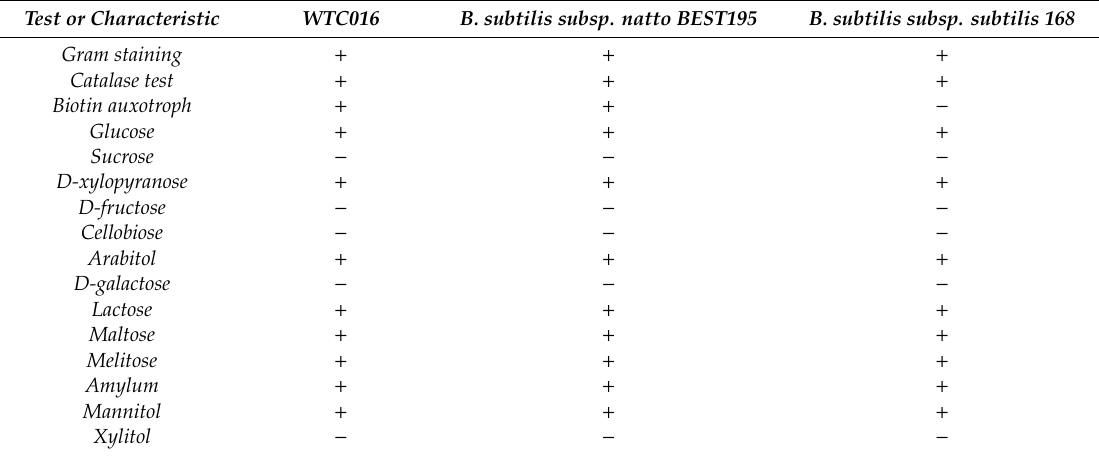
Table 2. Physiological and biochemical identification of WTC016 *.